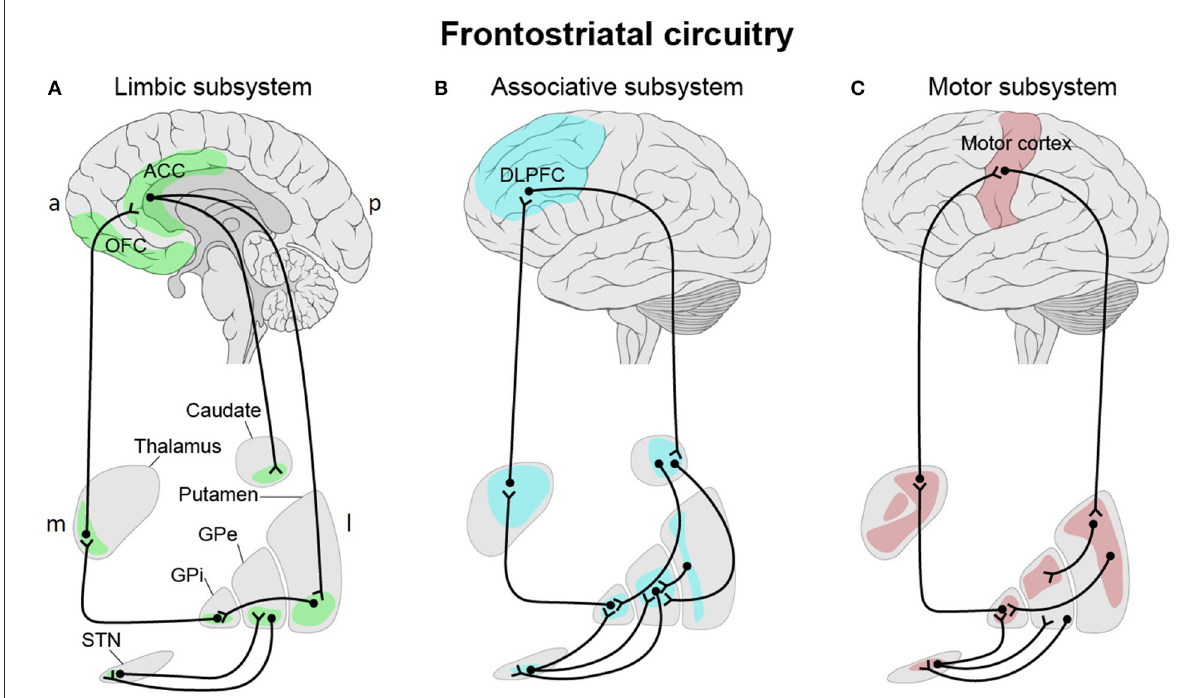
FIGURE1 Three-part organization of the frontostriatal circuitry with distinct “limbic” (A) , “associative” (B) , and “motor” (C) subsystems linking the frontal cortical regions and the striatum. (A) The “limbic” subsystem is divided into two parts. The first part originates in the lateral orbitofrontal cortex (OFC) and projects to the ventromedial sector of the caudate nucleus. This region innervates the dorsomedial globus pallidus interna (GPi) and rostromedial substantia nigra (SNr, not shown). The latter projects to the ventral anterior thalamic nucleus, magnocellular part and the mediodorsal thalamic nucleus, magnocellular part before it forms a closed loop with the lateral OFC. Both the anterior cingulate cortex (ACC) and medial OFC project to the ventral striatum (ventromedial caudate, ventral putamen, nucleus accumbens and olfactory tubercle) which in turn project to the rostrolateral GPi and the rostrodorsal SNr. Via the mediodorsal thalamic nucleus, magnocellular part, the SNr sends fibers back to the ACC and medial OFC. (B) Within the “associative” subsystem, the dorsolateral prefrontal cortex (DLPFC) projections terminate in the dorsolateral head of the caudate nucleus. The caudate nucleus projects to the dorsomedial part of the GPi and globus pallidus externa (GPe) and from there to the rostral portions of the SNr. The GPi closes the loop via the parvocellular portion of the ventral anterior thalamic nucleus to the DLPFC. (C) Motor-relevant cortical areas (motor, premotor, supplementary motor, and somatosensory cortices) innervate the caudal putamen, which sends input to the ventrolateral GPi and GPe and to the caudolateral portions of the SNr. The GPi sends input to the ventrolateral nucleus of the thalamus, which in turns forms a closed loop with the motor cortex. In all three subsystems, the subthalamic nucleus (STN) modulates input to the thalamus via the GPi and/or GPe. a, anterior; p, posterior; m, medial; l, lateral. This figure adapted from Obeso et al.